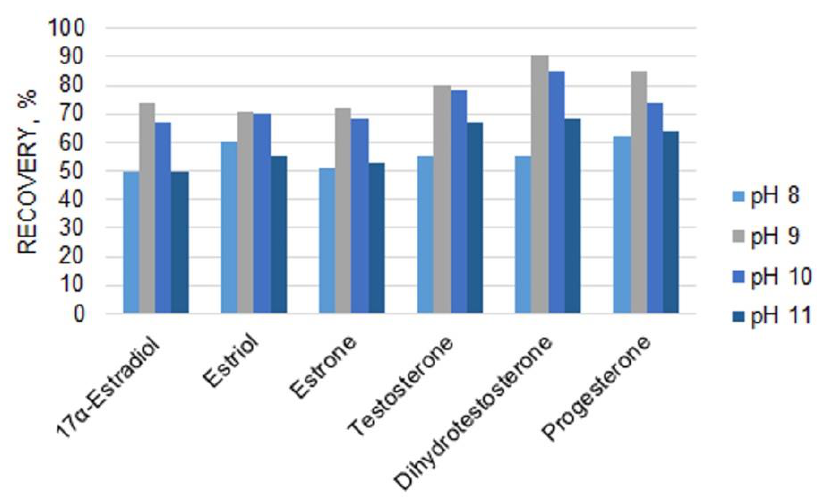
Figure 2. Influence of pH on steroid hormone recoveries for LLE with diethyl ether. Table 3. Comparison of different methodologies for sample preparation used for steroid determination.